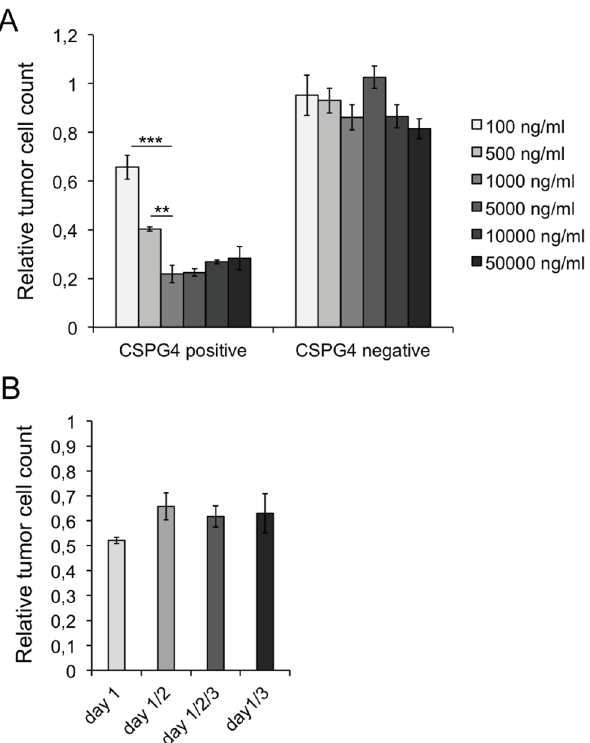
Fig 5. Dose and time dependency of r28M actions. Results from tumor cell viability measurements show samples normalized to the controls. Cells incubated without r28M served as controls, their number was considered as 1. Values are means ± SE. Significance levels: x: p (cid:1) 0.05; xx: p (cid:1) 0.01; xxx: p (cid:1) 0.001. PBMC from two different donors were used for the shown experiments. (A) CSPG4 positive (IPC-298) and